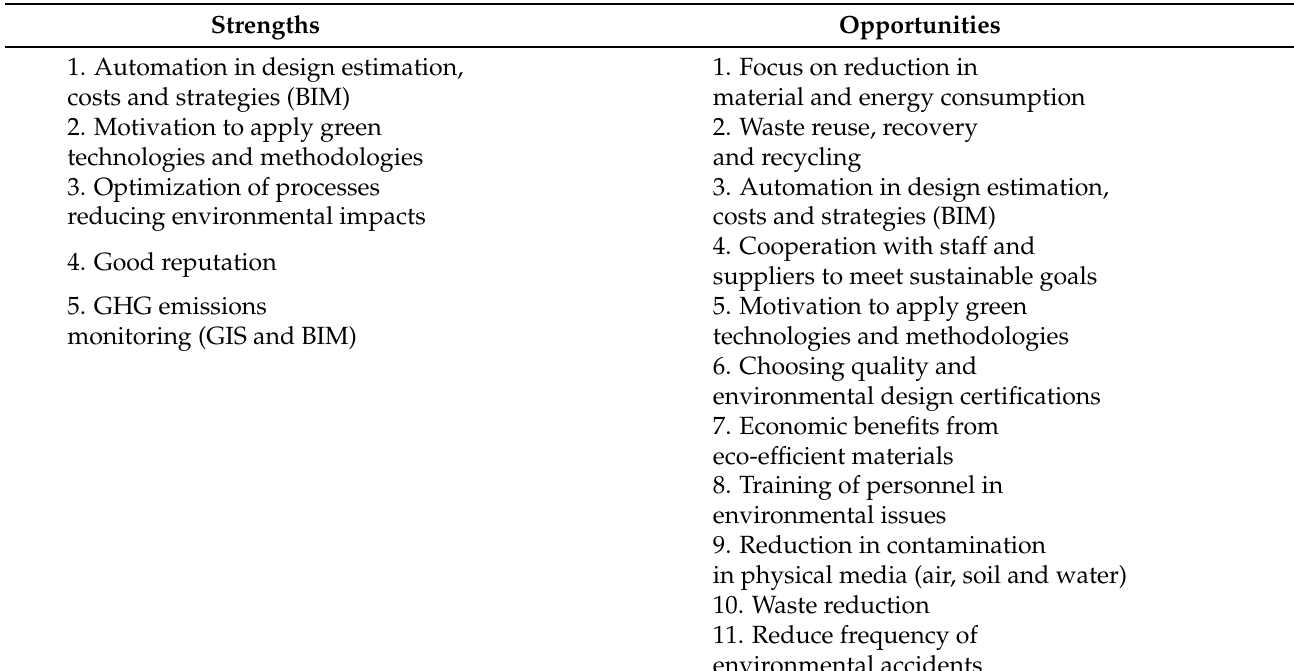
Table 5. SWOT analysis obtained from the